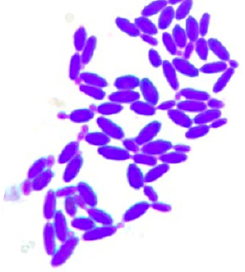
Figure 1. Optical micrograph of Pichia kudriavzevii 4A (40×).